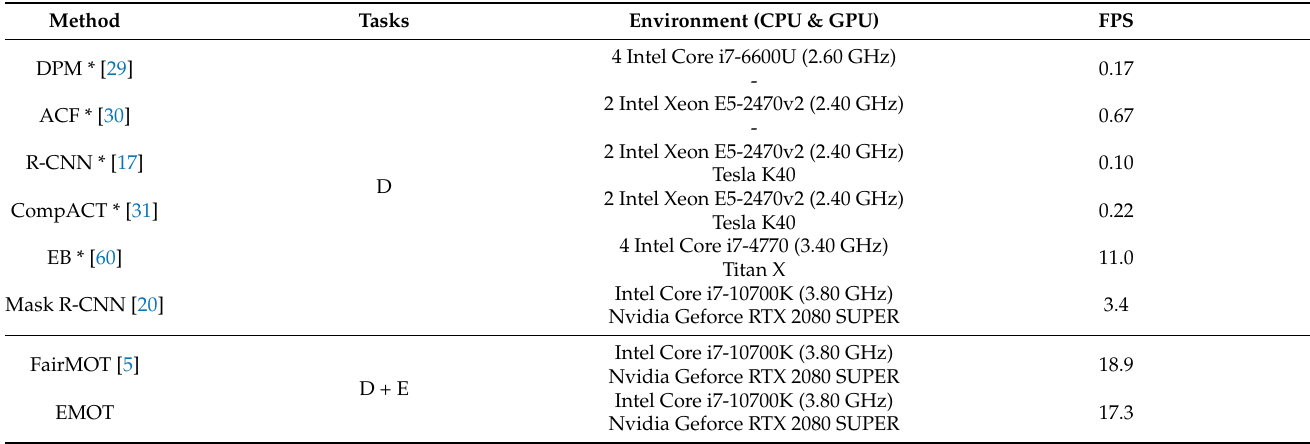
Table 6. Inference speeds of our single-shot MOT system and different methods. Legends: D-object detection; E-embedding extraction. The results of * were taken from Wen et al. [11].